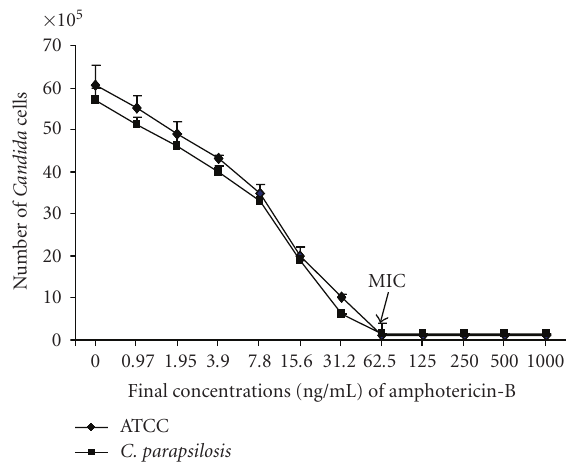
Figure 1: Sensitivity of C. parapsilosis to amphotericin-B. The yeast was cultured in the presence of various concentrations of amphotericin-B for 24 hours and its growth was assessed by MTT assay. Quantification of live C. parapsilosis was obtained using a standard live curve. The e ff ect of the antifungal agent on C. parapsilosis was compared to that on C. albicans . Results are presented as means ± SD of six di ff erent experiments.